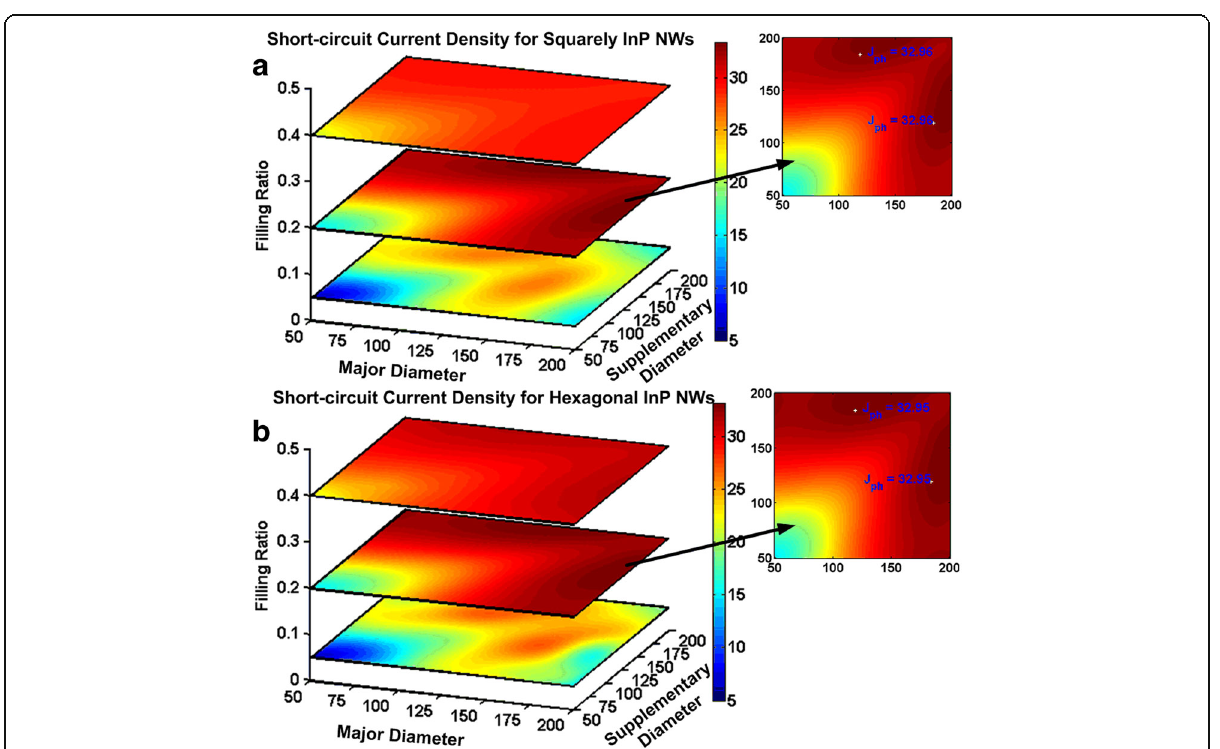
Fig. 6 Short-circuit current densities as a function of major, supplementary diameters, and FRs. a Squarely and b hexagonal InP NW arrays where the insets show optimal diameters for respective NW